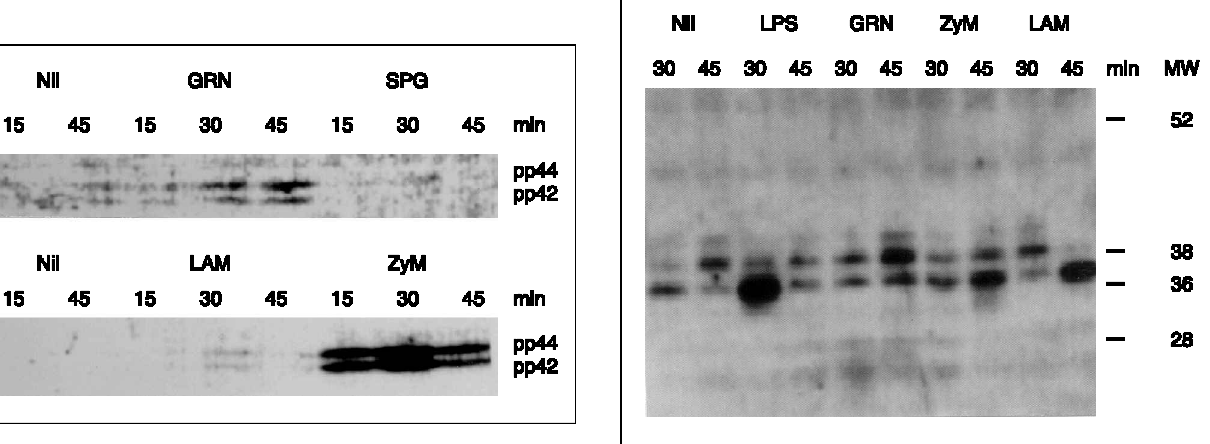
Fig. 3. Phosphorylation of mitogen-activated protein kinase in macrophage lysate induced with various stimuli. GRN, grifolan; SPG, sonifilan; LAM, laminarin; ZyM, zymosan.